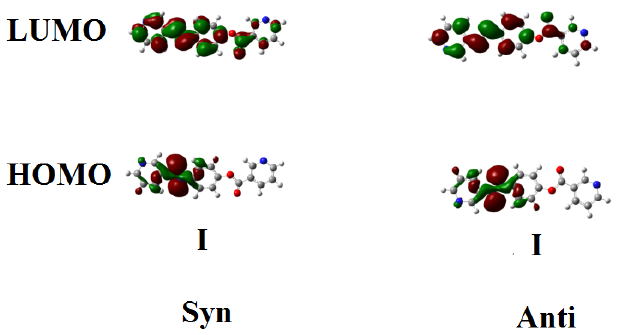
Figure 2. The estimated plots for frontier molecular orbitals of both conformers of dinitrogen base I .